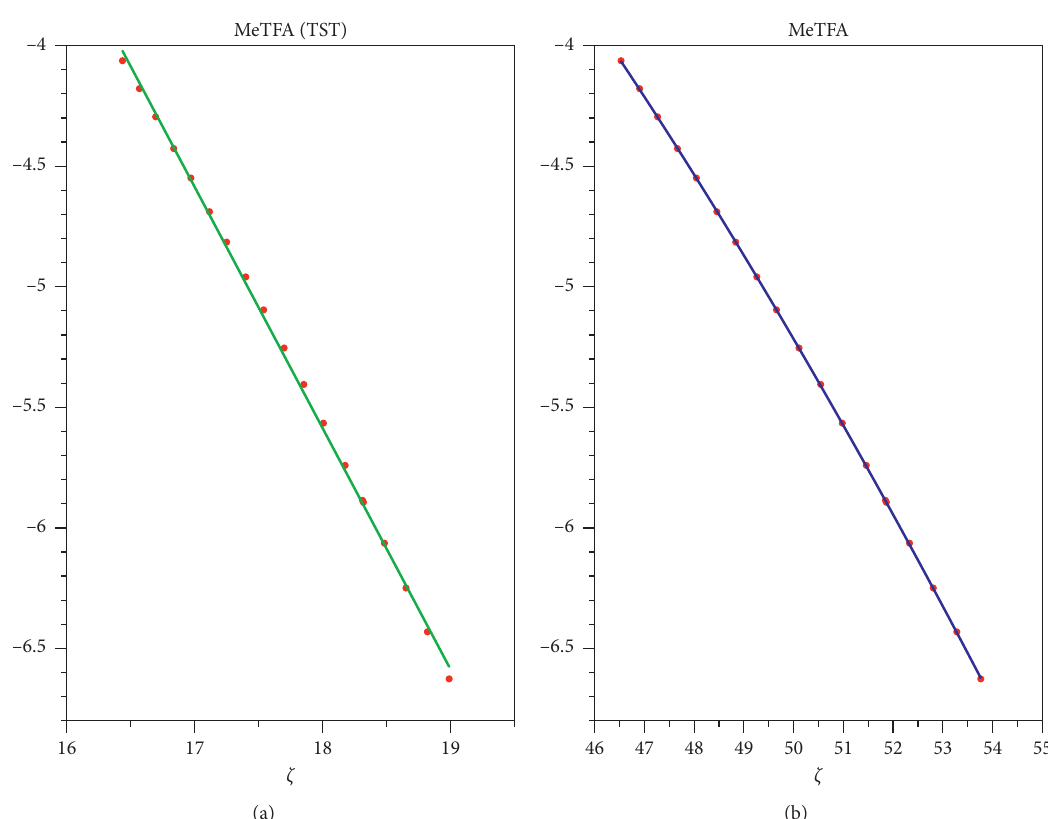
Figure 3: Eyring plots [3] according to TST (green) of rate coefficients for the neutral hydrolysis of methyl trifluoroacetate (MeTFA) in ( H O/DMSO ) . The corresponding curve from equation (8), with a � 35 , ] ( z 2 blue and the experimental data in